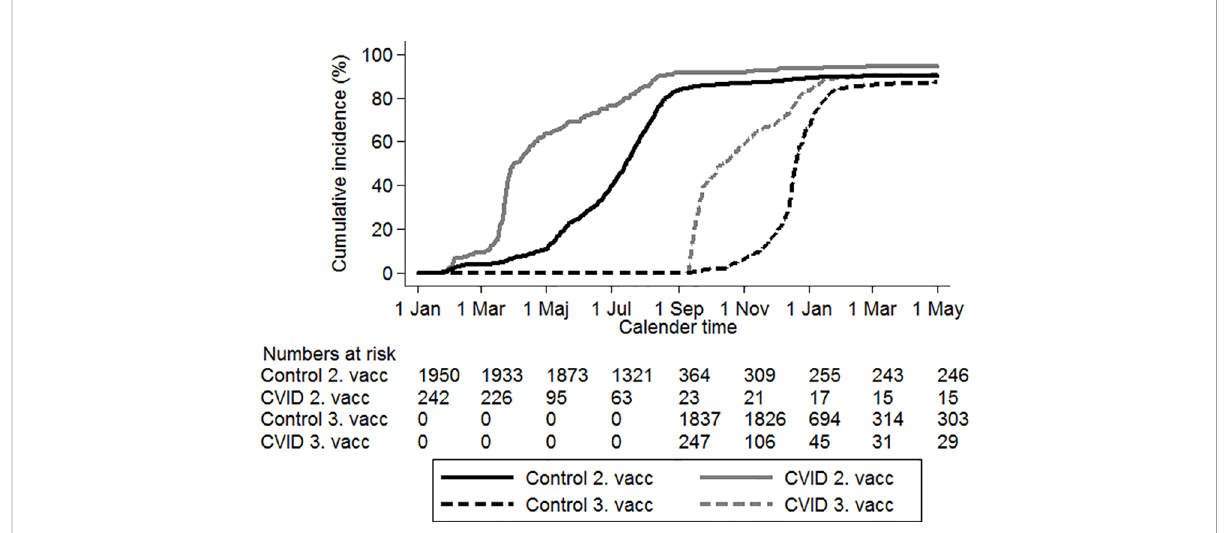
FIGURE 1 Time to second and third SARS-COV-2 vaccination. Black lines: population controls, gray lines: CVID patients. Solid lines: second vaccination, dotted lines: third SARS-CoV-2 vaccination. Time starts on January 1, 2020 and ends on May 1,